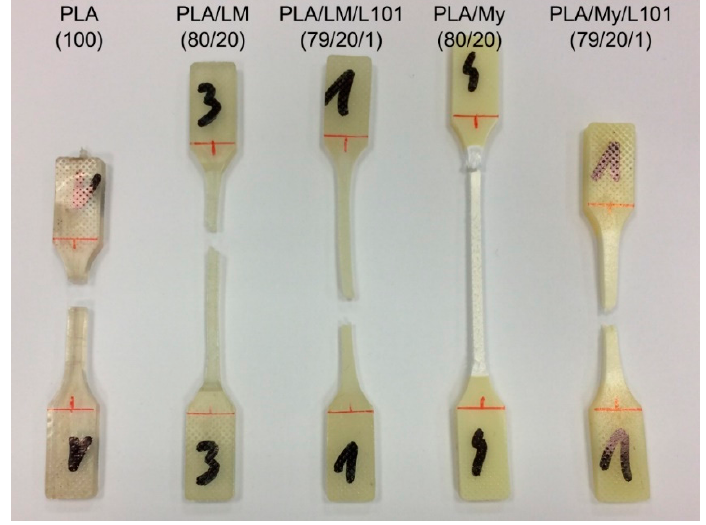
Figure 8. Pictures of drawn tensile specimen until failure of polylactide (PLA)-based materials.